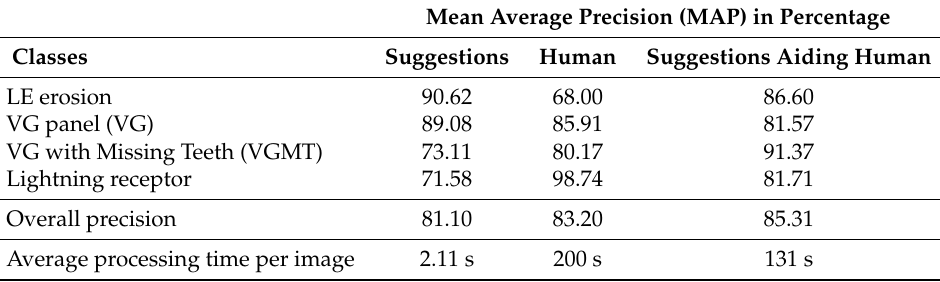
Table 3. Summary of the experimental